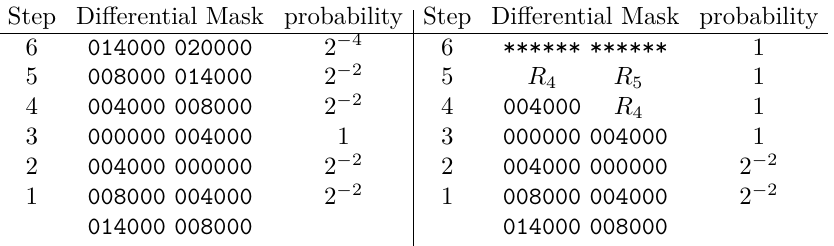
Table 4: Differential Propagation for 6-Round or 5-Round Simeck48